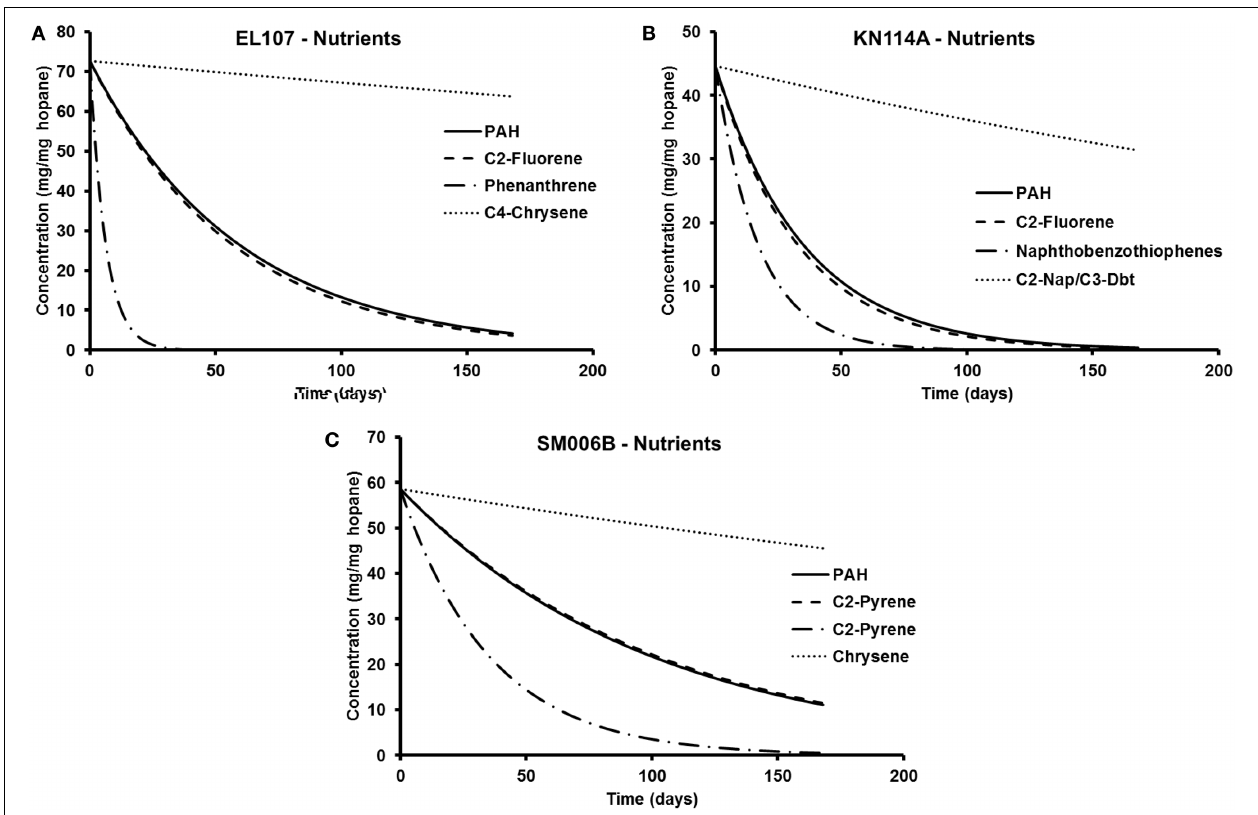
FIGURE 7 | Comparison of the temporal variation for different compounds in nutrient-amended experiments for (A) EL107, (B) KN114A, and (C)